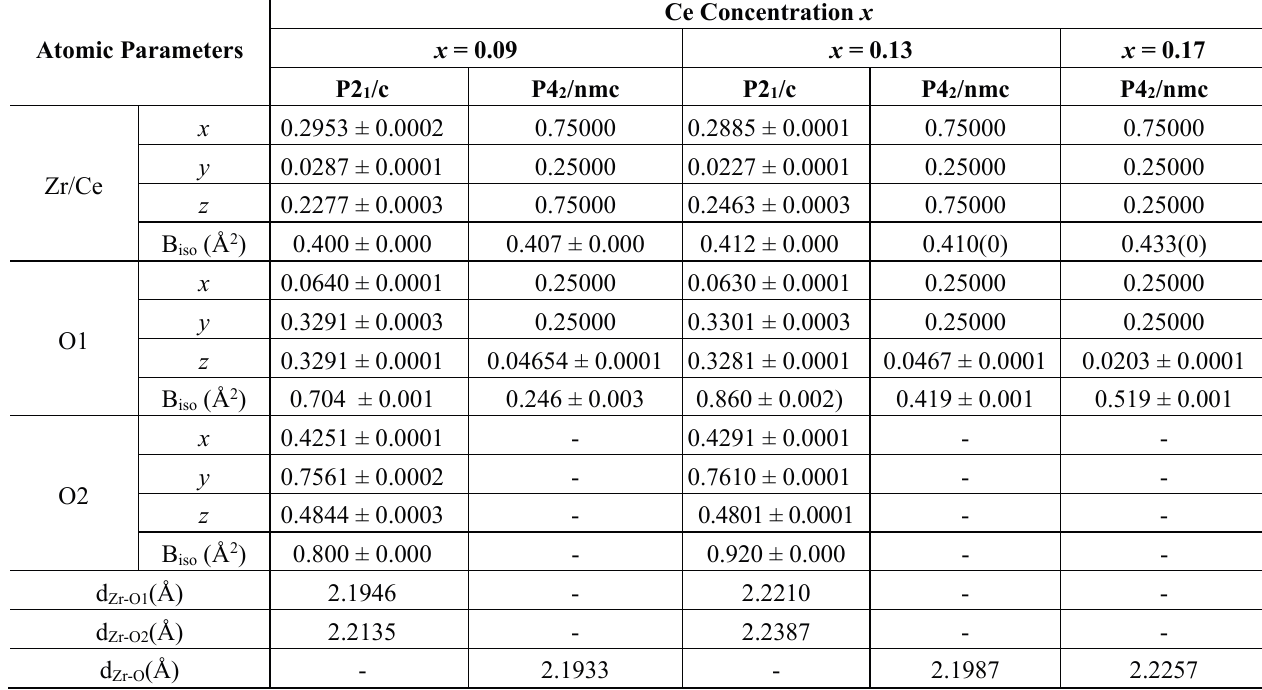
Table 4. Atomic positions, isotropic thermal parameters, and Zr-O distances of Zr 1- x Ce x O 2 ( x = 0.9–0.17) calculated using the Rietveld method from XRD data. (P 2 1 /c: Zr (4e) ( xyz